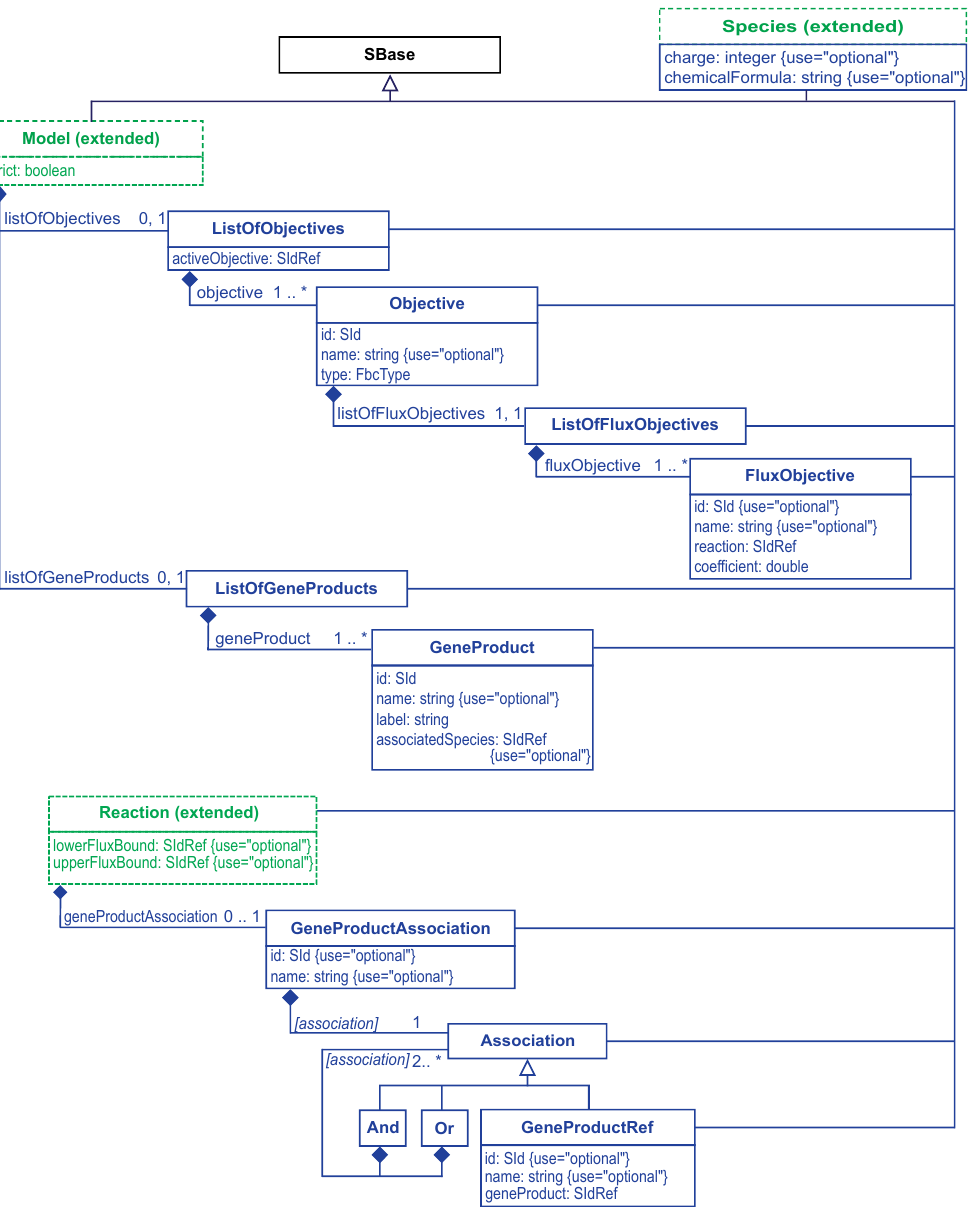
Figure 1: A UML representation of the Flux Balance Constraints package. Derived from SBase , the FBC classes inherit support for constructs such as SBML Notes and Annotation ’s. The [association] element name is the name of the class, de-capitalized. In this case, the possible values are "and", "or", or "geneProductRef". See Section 1.4 for conventions related to this figure. The individual classes are further discussed in the